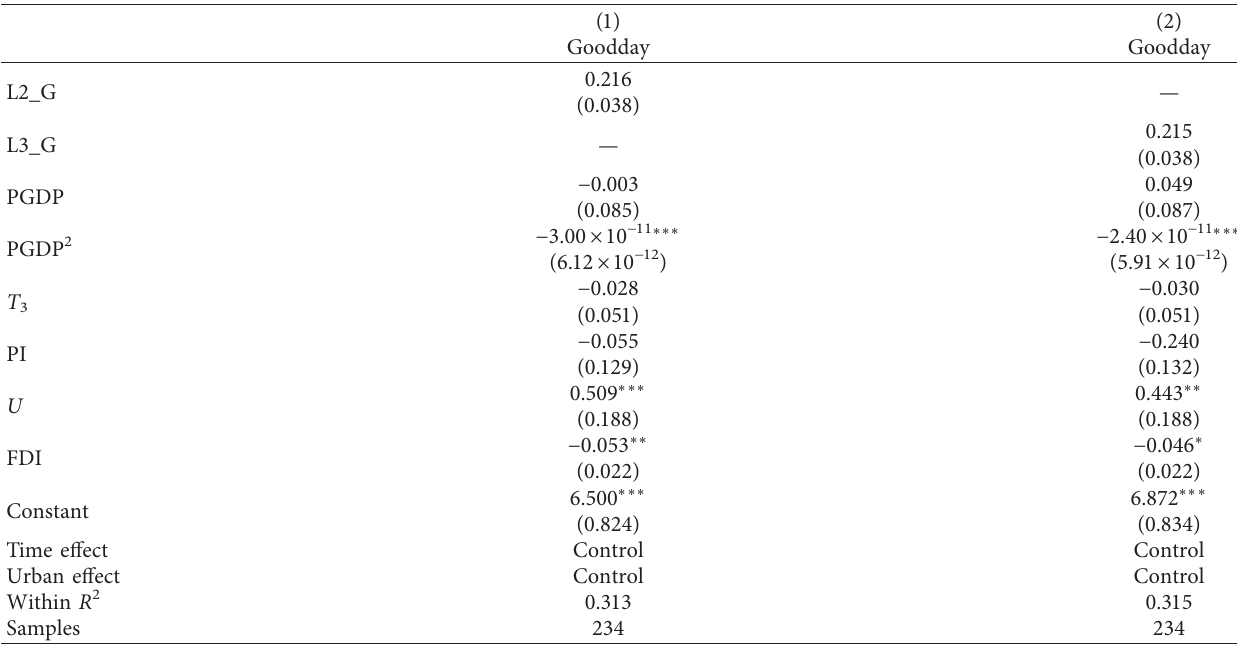
Table 4: Counterfactual experiment results.